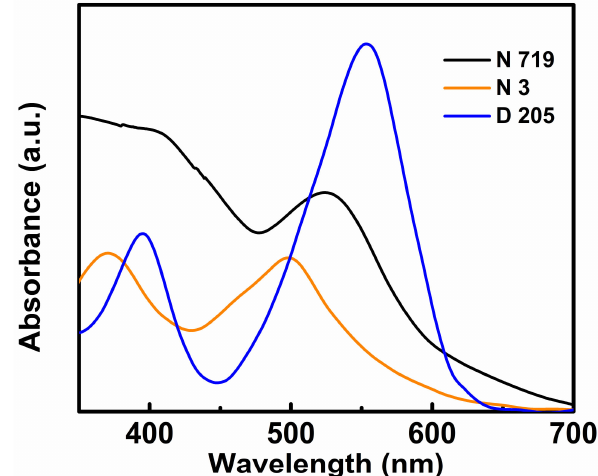
Figure 5. Absorption spectra of some widely used dyes in DSSCs for indoor application. (Reproduced from [69,70], with permission from RSC Publishing, 2011 and ACS Publications, 2009